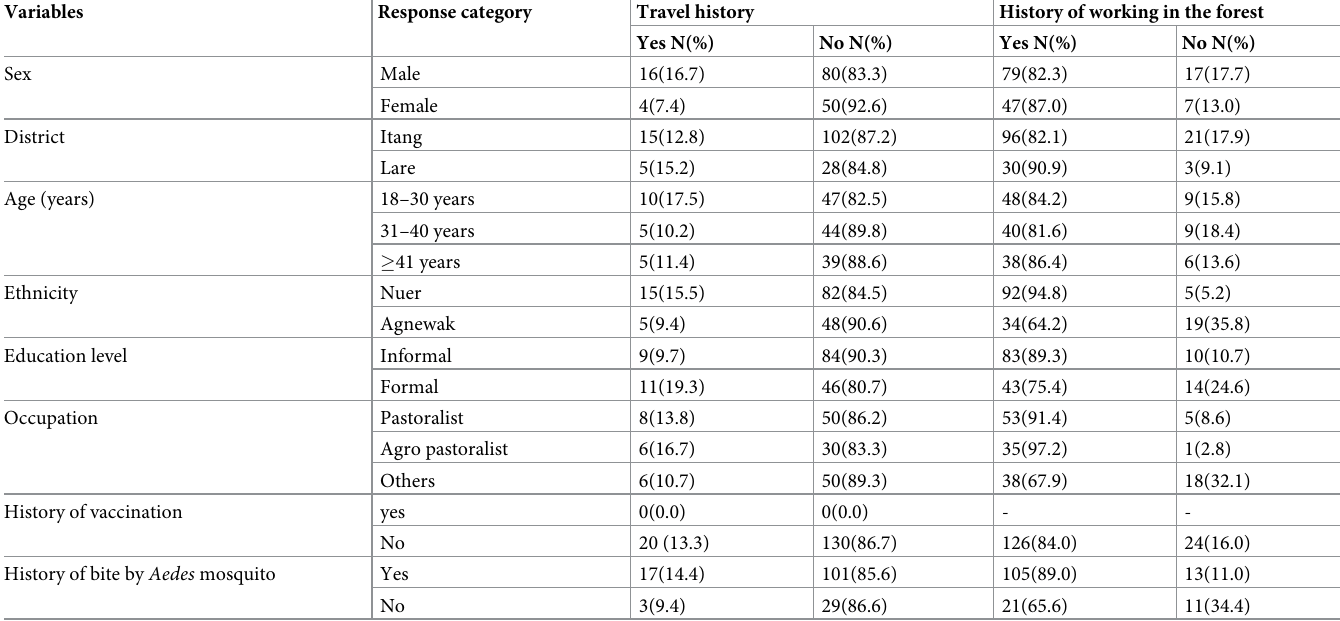
Table 1. Socio-demographic characteristics (N =